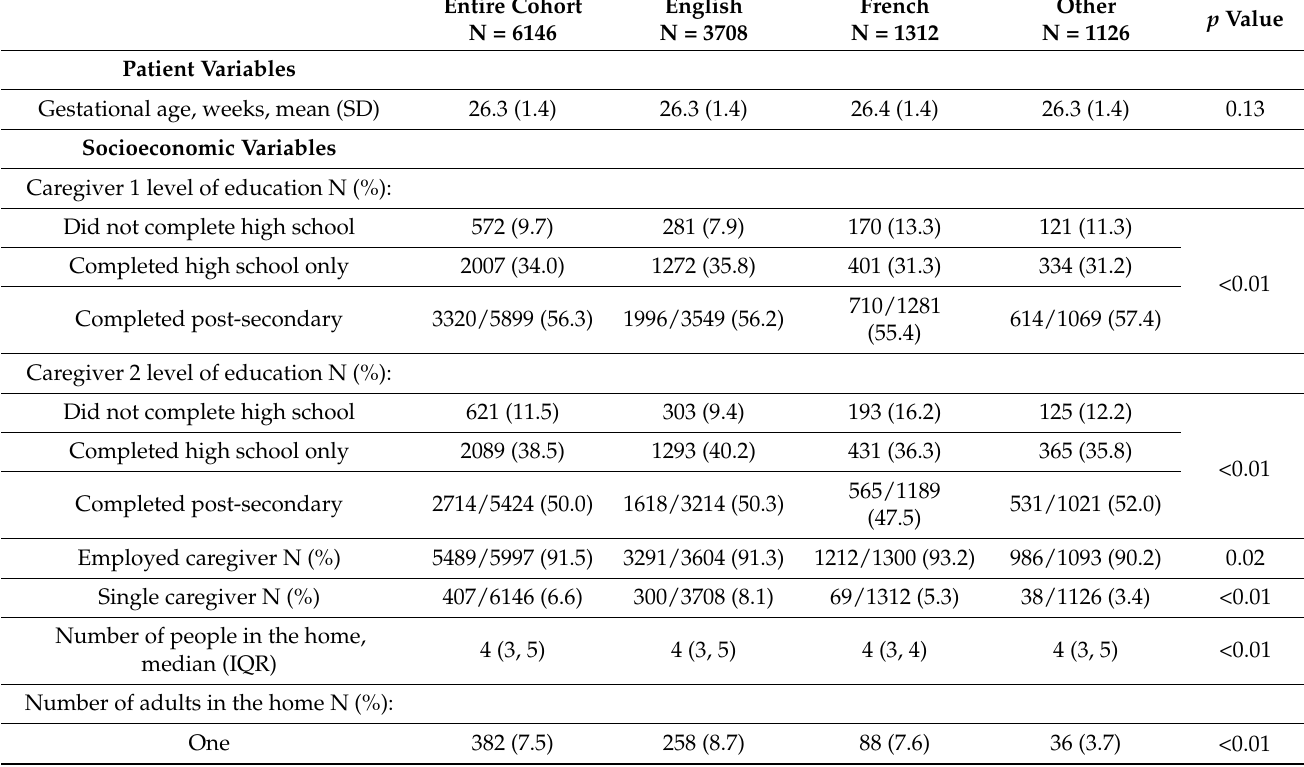
Table 1. Characteristics of preterm infants (born at <29 weeks’ GA) included in the study. Entire